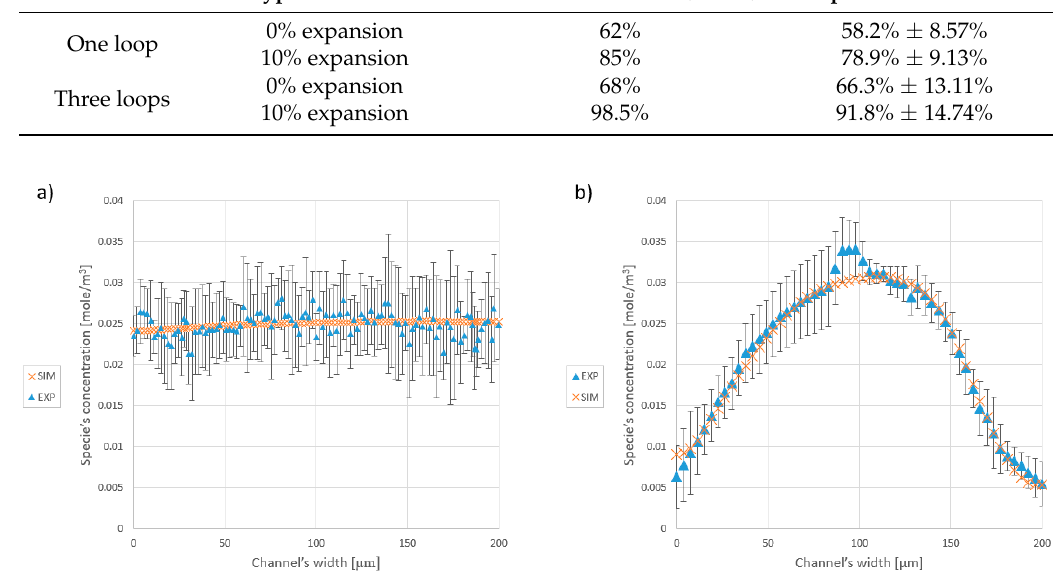
Figure 8. Concentration of the species at the cross-section of the outlet. ( a ) The graph represents the distribution of species at the outlet of the three loops mixer with 10% expansion. ( b ) Species distribution at the outlet of the one loop mixer without the expansion